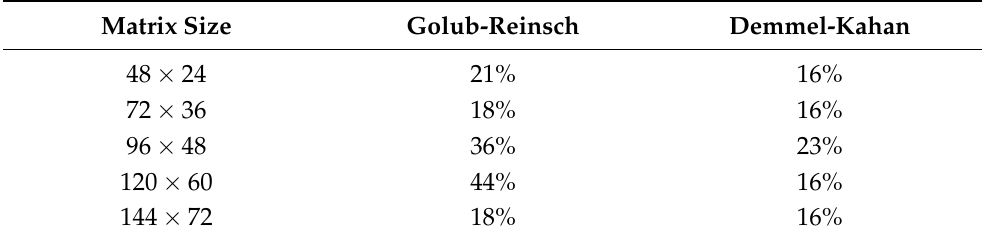
Table 4. Speed increase from optimized matrix multiplication